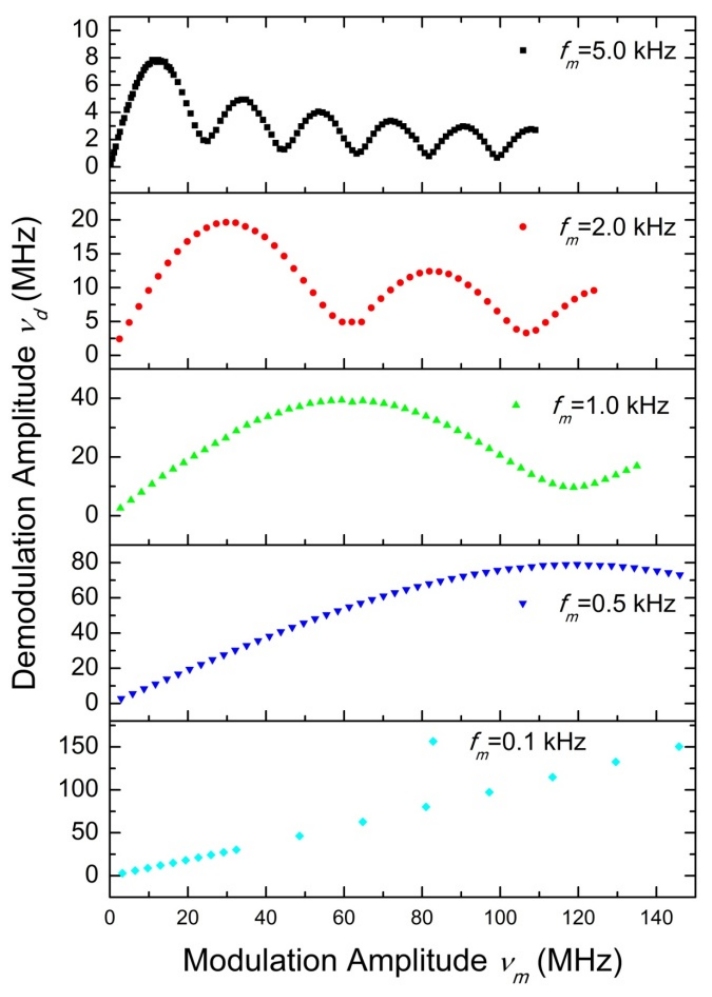
Figure 3. The demodulation frequency amplitude ν d with respect to the modulation amplitude ν m at different modulation frequencies f m of 0.1 kHz, 0.5 kHz, 1.0 kHz, 2.0 kHz, and 5.0 kHz, respec- tively.